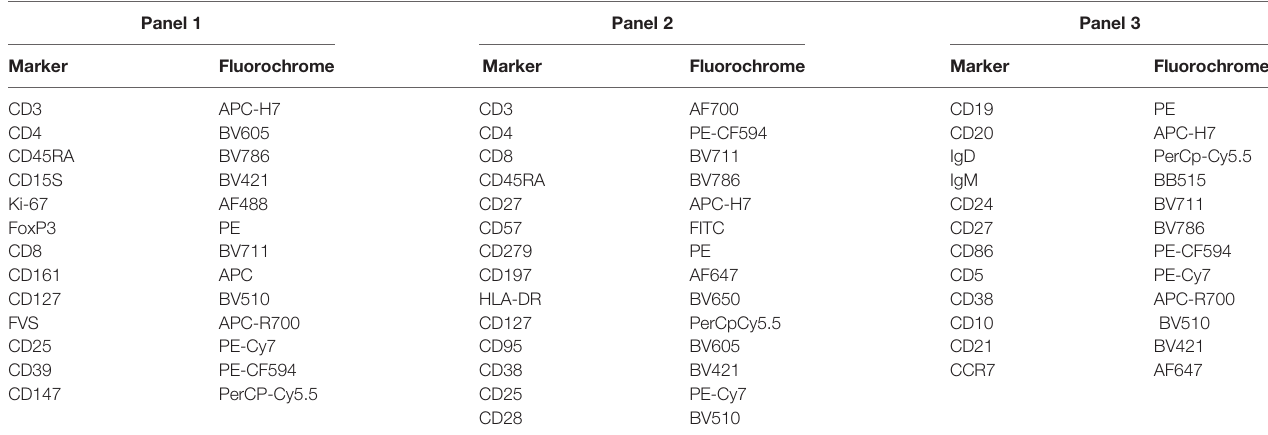
TABLE 1 | FACS panels used to characterize T and B cells in peripheral